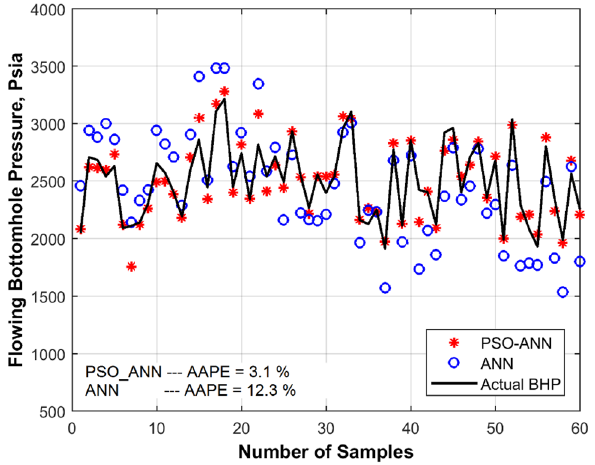
Fig. 5 FBHP prediction using optimized and unoptimized models (testing dataset)